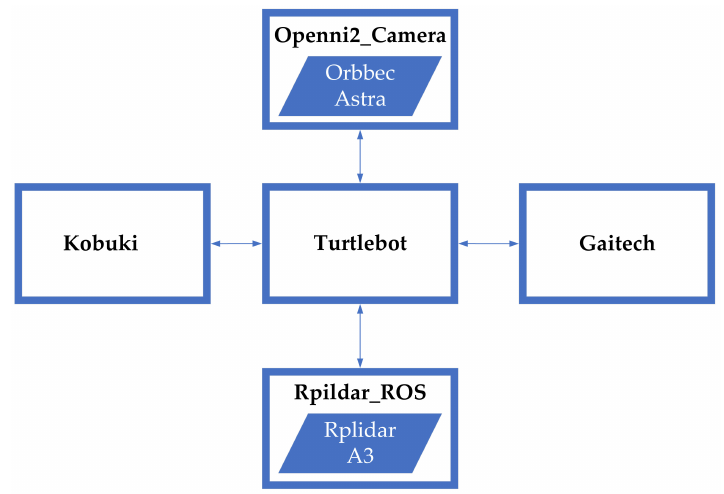
Figure 8. Turtlebot block